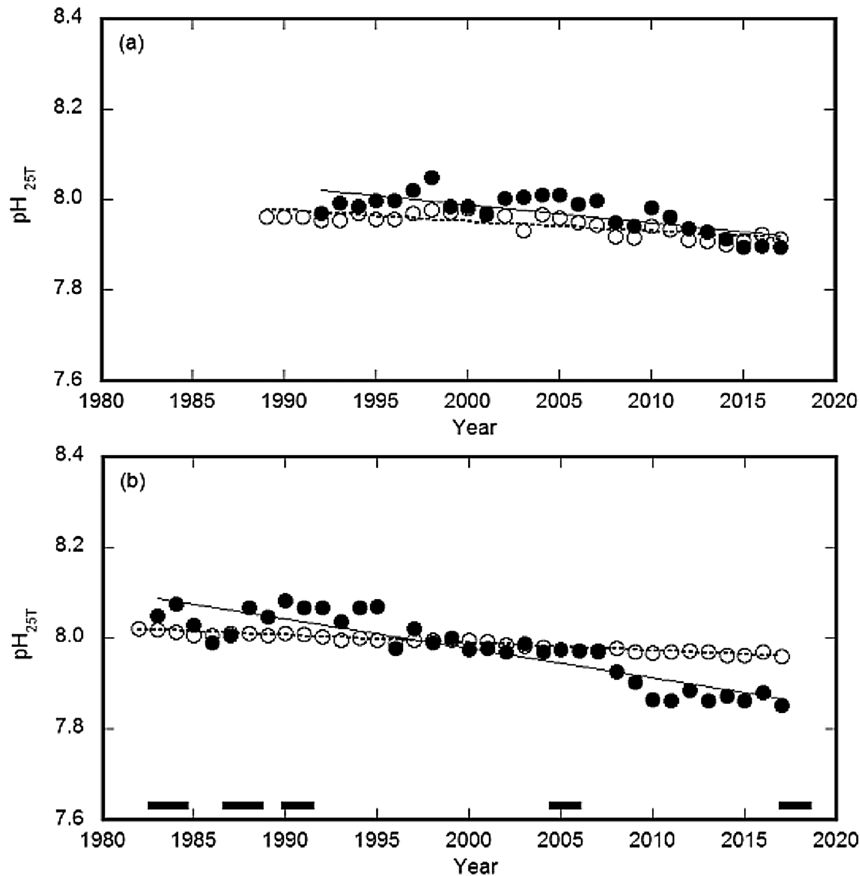
Figure 3. Comparison between the mean annual oceanic pH 25T time-series for the observed and expected values for the coastal regions of the Sea of Japan and North Pacific. The Demonstration Laboratory (DL) on the Sea of Japan coast (a) and Central Laboratory (CL) on the Pacific Ocean coast (b) . White circles show theoretical values and black circles show annual observation averages. The dashed line indicates the linear trends in the theoretical variability for the DL and CL; these decreasing trends are 0.0022 and 0.0016 year –1 , respectively. The solid line shows the linear trend in the annual observation averages for the DL and CL; these slopes are identical to the annual averages, which are – 0.0037 and – 0.0064 year –1 , respectively. The thick solid lines show the periods during which Kuroshio meandering was